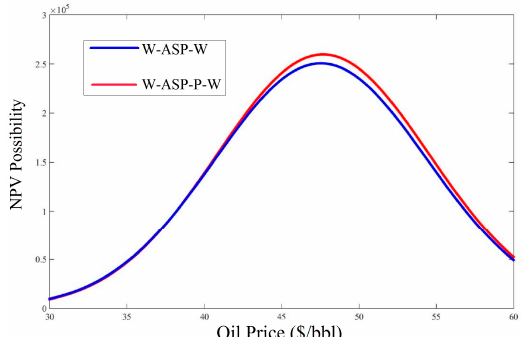
Figure 13. NPV possibility curves following the normal distribution of the oil price for the most optimal case of two sequences.